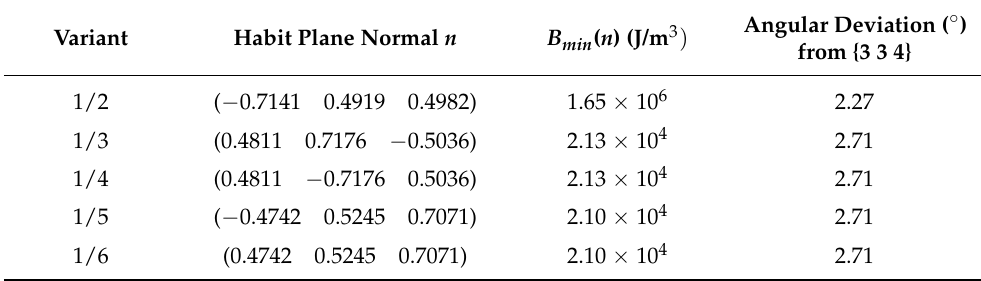
Table 9. Predicted habit plane normal, minimum B pq ( n ) and angular deviation with twinned variants.